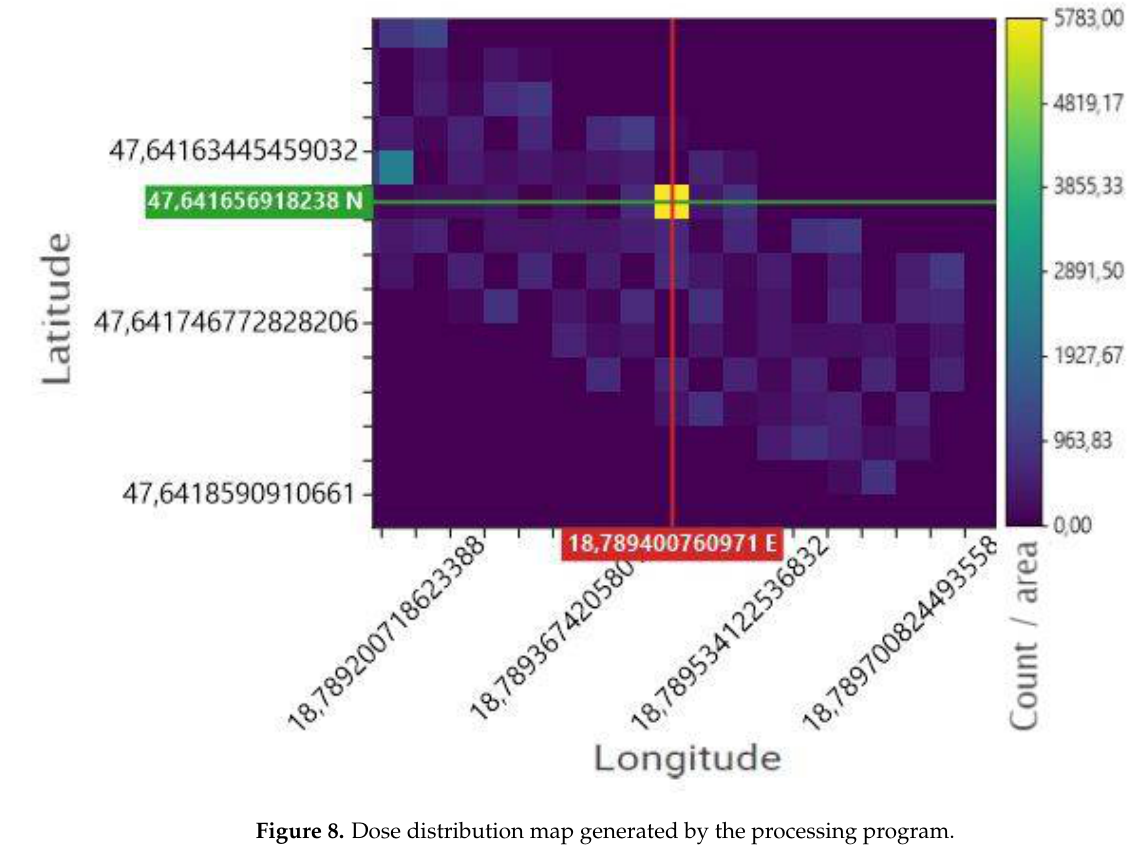
Figure 8. Dose distribution map generated by the processing program.